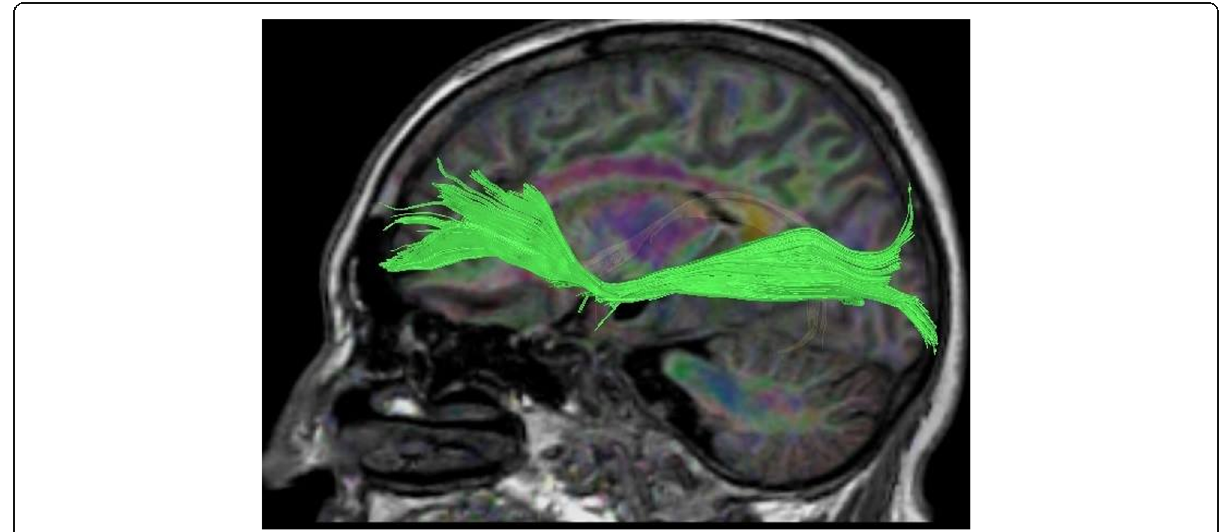
Fig. 2 Sagittal view of the detailed tractography of the right superior longitudinal fasciculus (SLF) in a diabetic subject with mild cognitive impairment. Color coding is included to assist with identification of the fibers in the images. Fractional anisotropy (FA) is reduced (0.239 ± 0.106) and mean diffusivity is elevated (MD) (0.986 ±